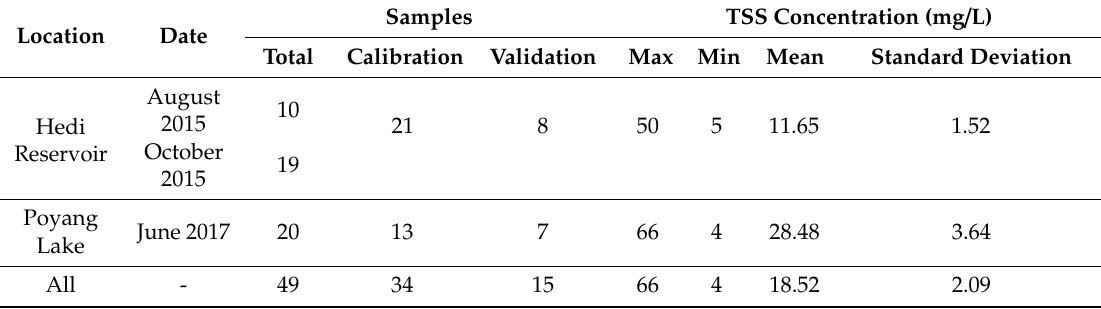
Table 1. Summary of total suspended solids (TSS) concentration (N = 49) from the synchronous in situ spectra collected at di ff erent sites during several in situ